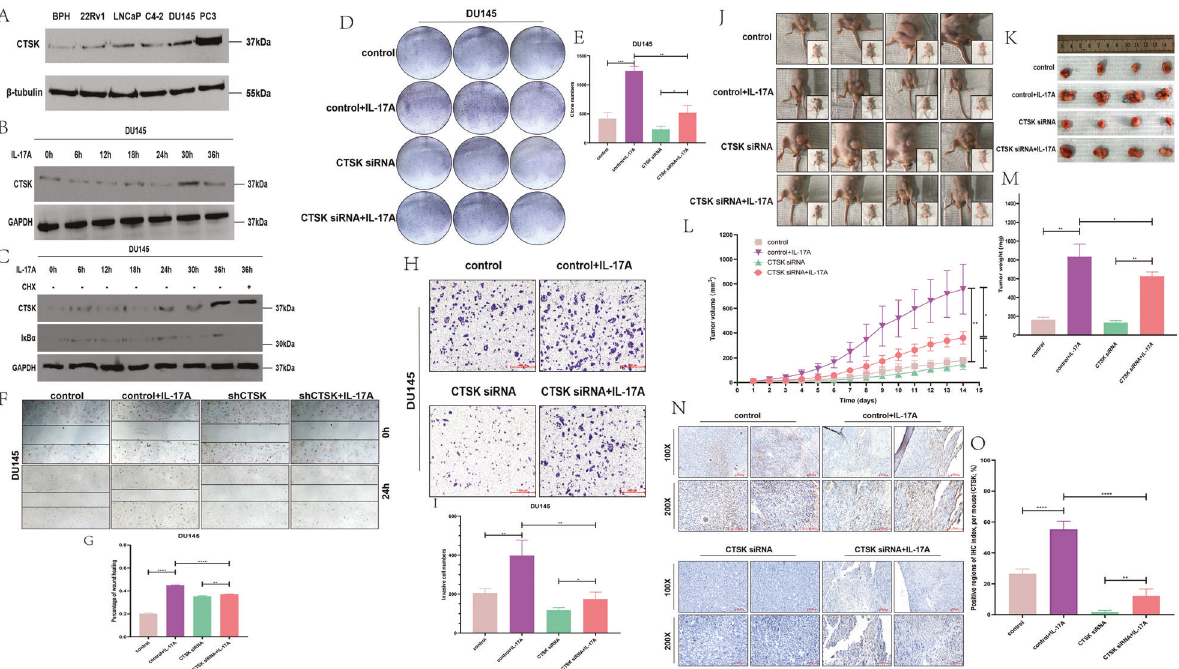
Fig. 3 Effect of IL-17A on the growth of prostate cancer cells via its in fl uence on the expression of CTSK both in vivo and in vitro. A WB assay to examine the CTSK protein expression in PC cells, β -tubulin protein served as control. B Treated with 15 ng/ml restructuring human IL- 17A in DU145 cells for 0, 6, 12, 18, 24, 30, and 36 h. WB assay to examine the CTSK protein expression, GAPDH protein served as control. C WB assay to examine the CTSK/I κ B α protein expression, GAPDH protein served as control. Treated with 15 ng/ml restructuring human IL-17A in DU145 cells for 0 – 36 h and one group is added 10 µg/ml CHX at 24 h and collected at 36 h. D DU145 cells are treated with control siRNA, IL- 17A, CTSK siRNA, CTSK siRNA + IL-17A, and conducted colony formation assay. E Quantization of D . F Wound healing assay in DU145 cells transfected with negative control siRNA, IL-17A, CTSK siRNA, CTSK siRNA + IL-17A. G Quantization of F . H Transwell assay in DU145 cells transfected with negative control siRNA, IL-17A, CTSK siRNA, CTSK siRNA + IL-17A. I Quantization of H . J , K DU145 cells treated with negative control siRNA, IL-17A, CTSK siRNA, CTSK siRNA + IL-17A are injected subcutaneously into the abdomen of mice. The effect of negative control siRNA, IL-17A, CTSK siRNA, CTSK siRNA + IL-17A on the growth of PCa. L Measuring tumor sizes of mice daily for 2 weeks when the tumor is 1.5 – 2 mm in diameter. M Quanti fi cation of tumors in different groups of mice in L . N , O Comparing CTSK expression in negative control siRNA, IL-17A, CTSK siRNA, CTSK siRNA + IL-17A groups by IHC